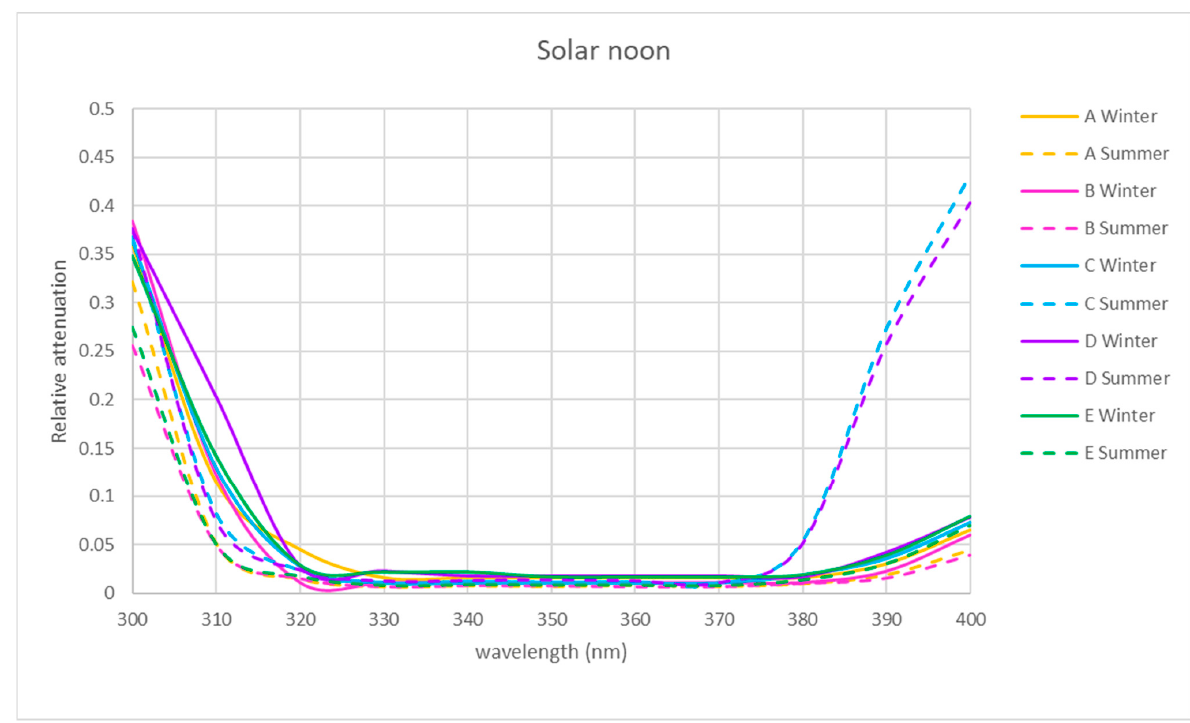
Figure 6. Representation of the spectral relative attenuation for the UV band for the 5 locations studied in the two seasons of the year at 15 h solar time.